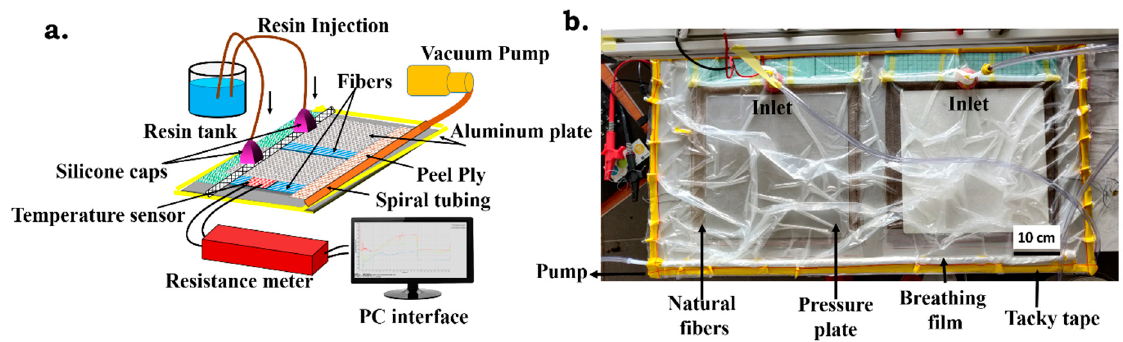
Figure 3. Vacuum infusion process: ( a ) schematic representation; ( b ) digital photograph.